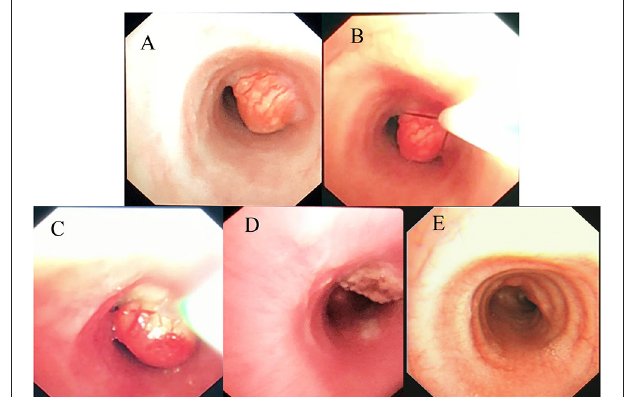
FIGURE 2 | (A) Fiberoptic bronchoscopy image of the large mass covered by smooth mucosa in the mid-tracheal region. (B) Placing the loop of the snare around the base of the mass. (C) The process of mass removal by electrocautery snare. (D) Most of the mass is removed by electrosurgical snaring under bronchoscopy. (E) Photograph showing a slight protrusion at the position of the incision at 1 year